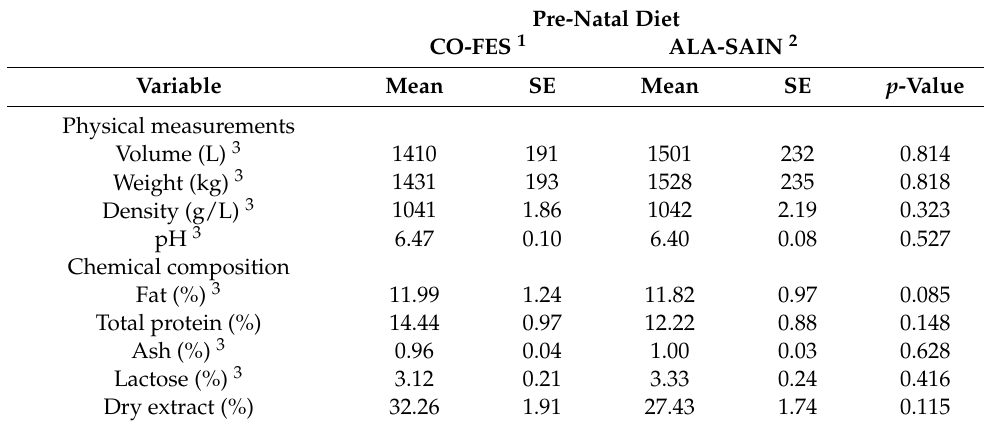
Table 2. Effect of pre-natal diet on colostrum physical measurements and chemical composition.